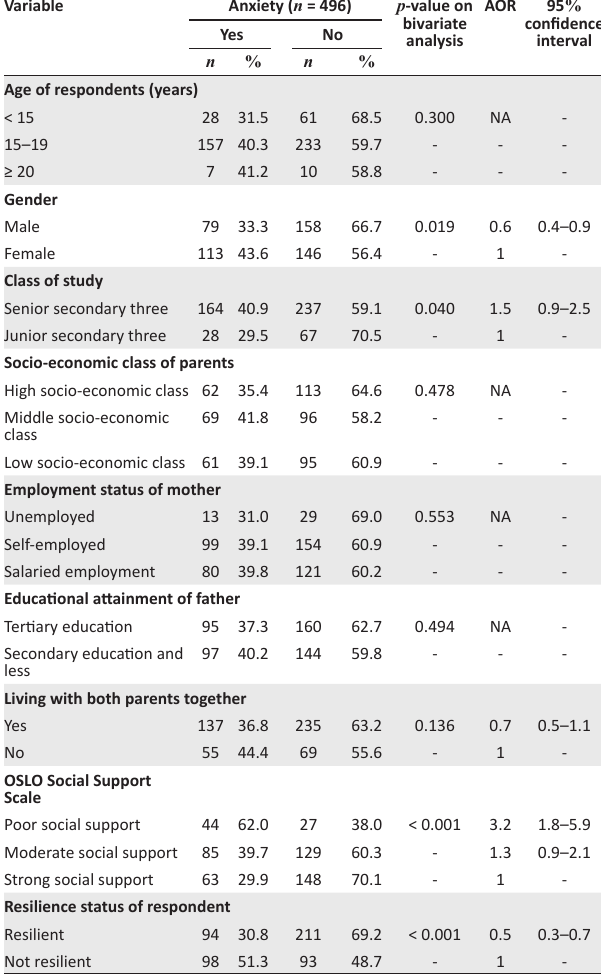
TABLE 3: Factors associated with depression amongst the respondents. TABLE 2: Factors associated with anxiety amongst the respondents.